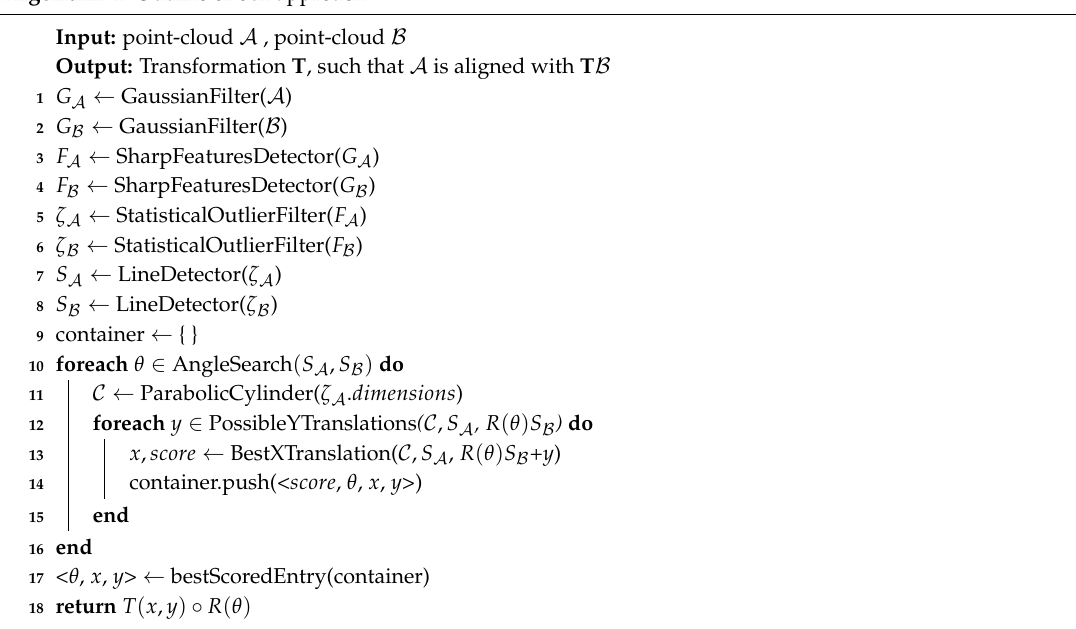
Algorithm 1 : Outline of our